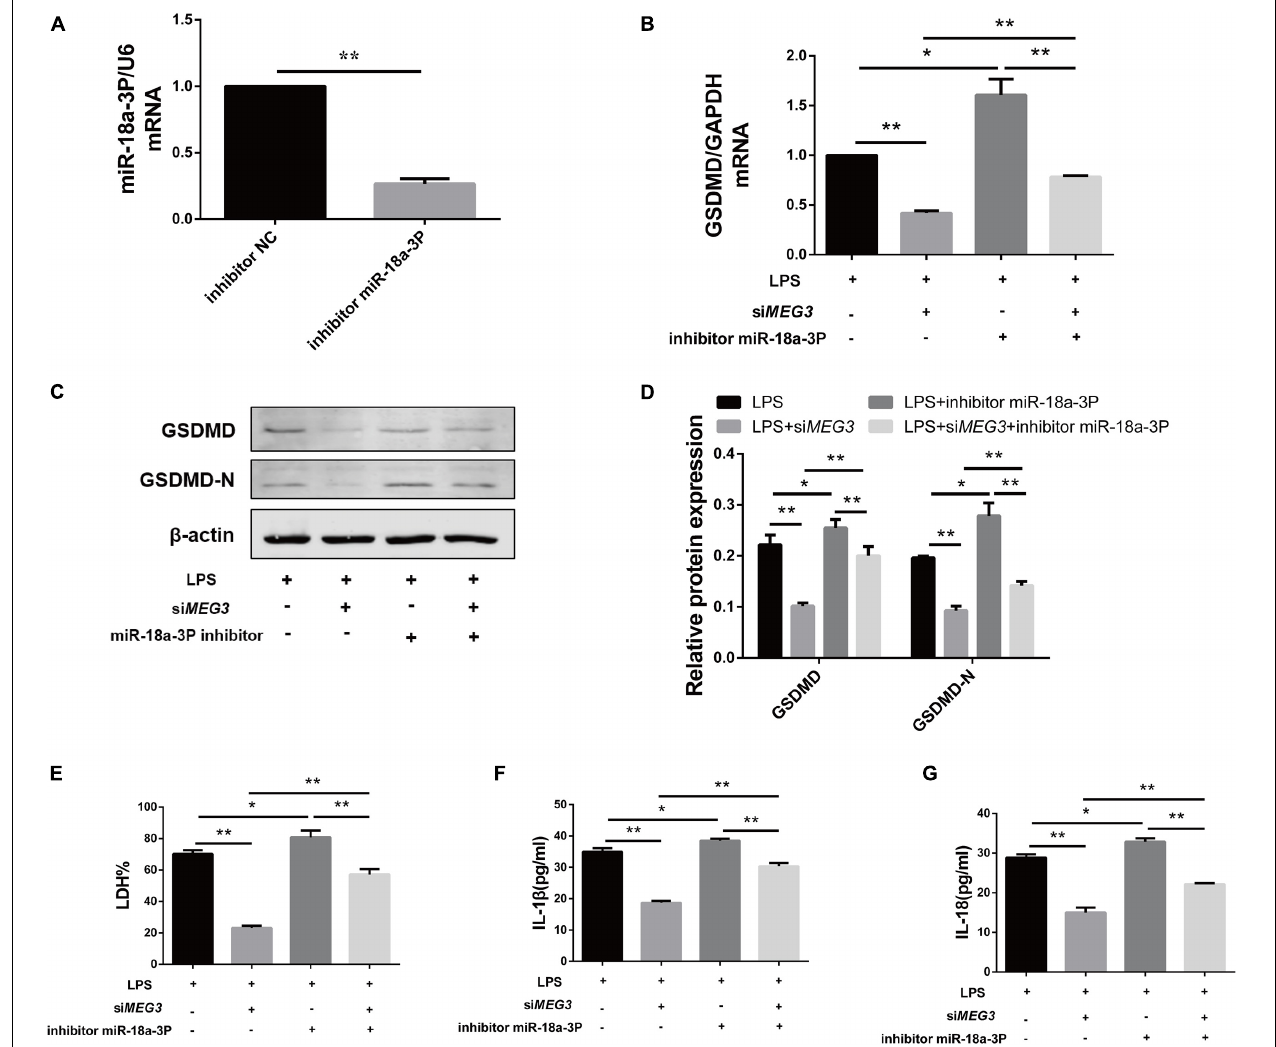
FIGURE 6 | Knocking down miR-18a-3p reversed the inhibitory effect of siMEG3 on pyroptosis in primary human TECs. (A) Expression level of miR-18a-3p mRNA in TECs transfected with inhibitor. (B) GSDMD mRNA expression level in TECs transfected with siMEG3 and miR-18a-3P inhibitor separately or together. (C,D) Protein expression levels of GSDMD and GSDMD-N in TECs transfected with siMEG3 and miR-18a-3P inhibitor separately or together. (E) LDH% in supernatants obtained from TECs transfected with siMEG3 and miR-18a-3P inhibitor separately or together. (F,G) Release of IL-1 β and IL-18 in supernatants obtained from TECs transfected with siMEG3 and miR-18a-3P inhibitor separately or together. * P < 0.05, ** P < 0.01, and compared with the respective control